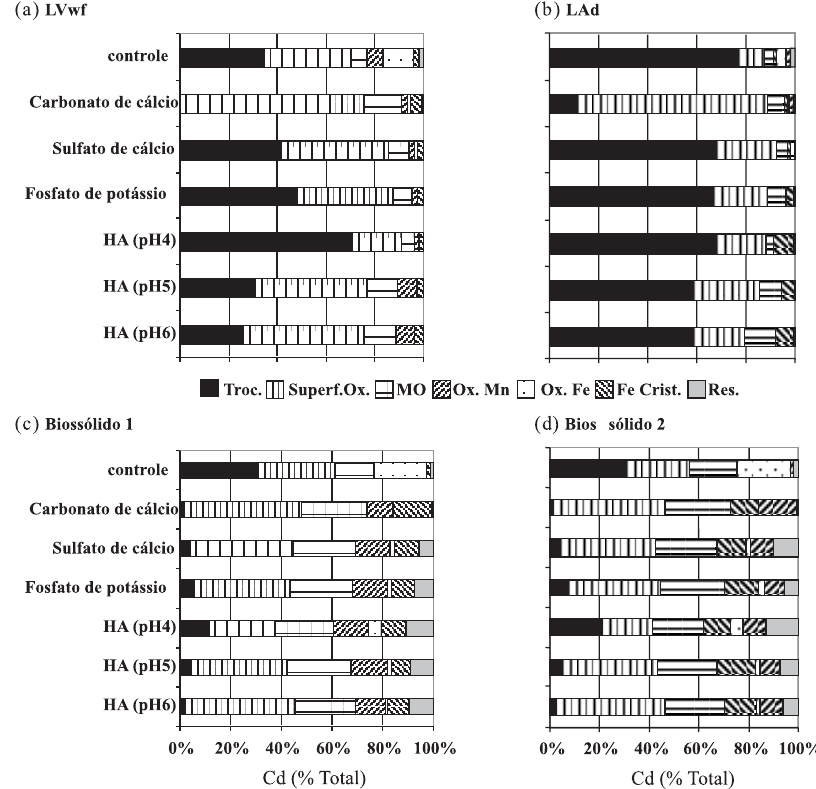
Figura 6. Distribuição das formas de cádmio nas amostras de solo e biossólido após os equilíbrios nas câmaras duplas de difusão. LVwf: Latossolo Vermelho acriférrico; LAd: Latossolo Amarelo distrófico;